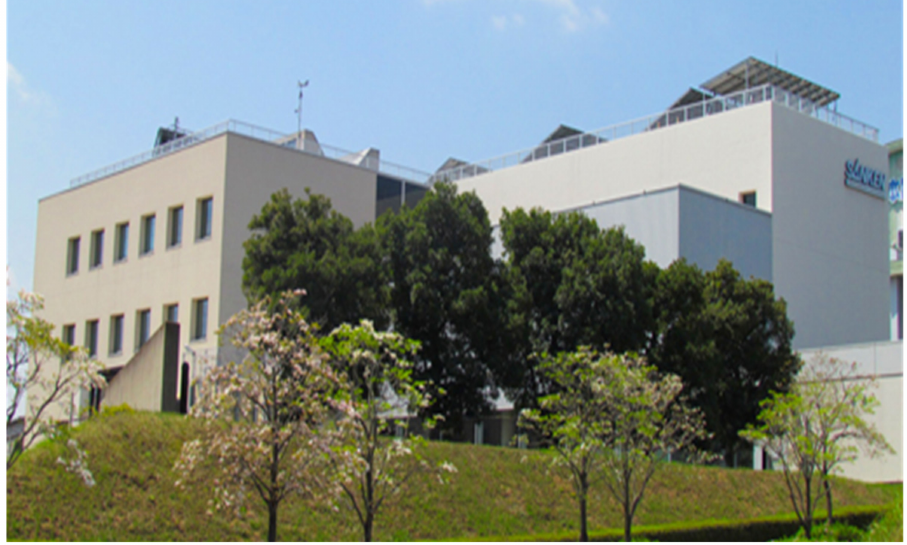
Figure 2. Photo of the target